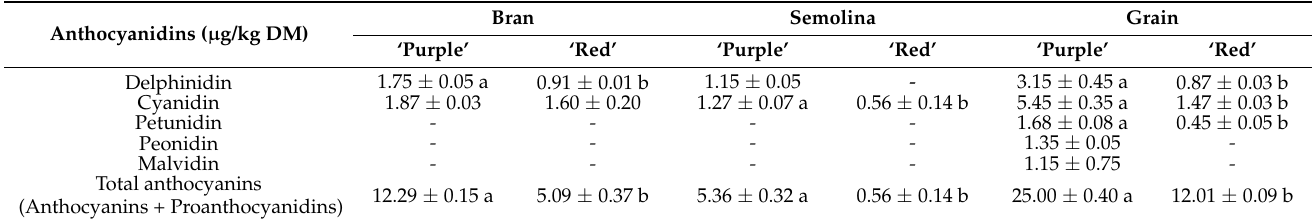
Table 6. Anthocyanidin composition in the ‘Purple’ and ‘Red’ (mean ± SD; n = 5) determined by HPLC. Values are reported as mean ± SD ( n = 5). Significant differences between the two varieties for bran, semolina, or grain are indicated by lowercase letters ( t -test, p < 0.05). Anthocyanidins ( µ g/kg